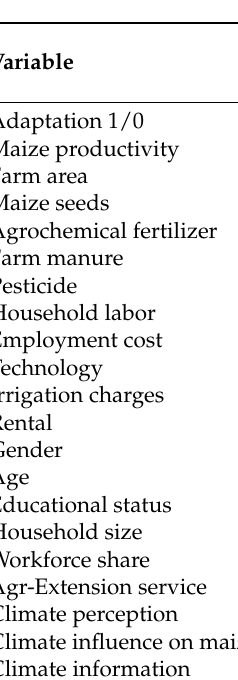
Table 2. Farmstead and farmers’ attributes of adopters and